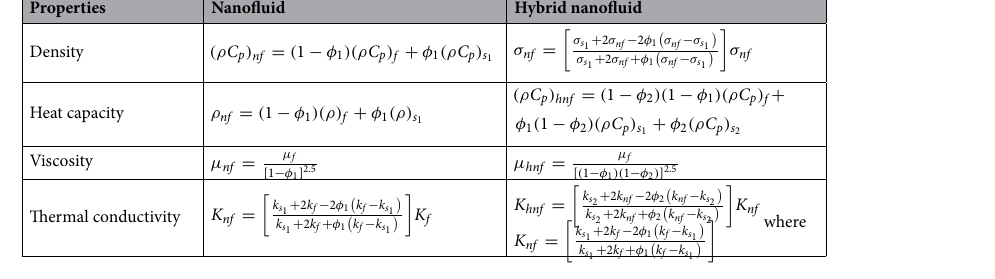
Table 1. Thermo-physical properties 53,54